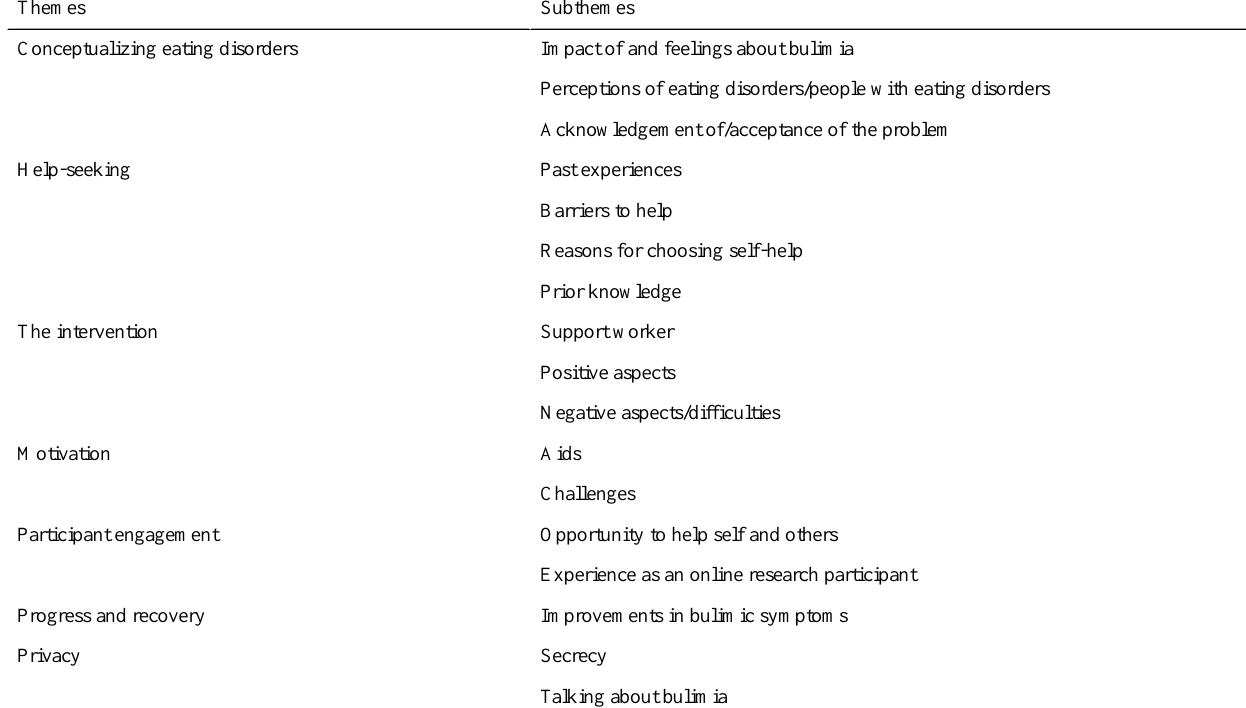
Table 1. Themes and subthemes identified in the semi-structured